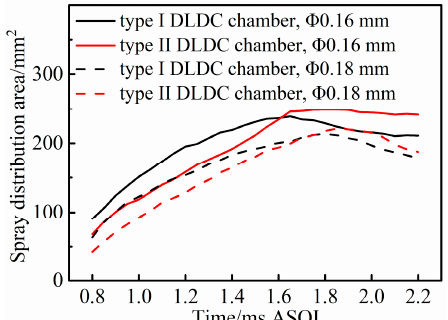
Figure 15. The comparison of fuel spray distribution areas between the two DLDC chambers with medium load, different nozzles, 150 MPa injection pressure and 5 °CA BTDC injection timing of Mode B.